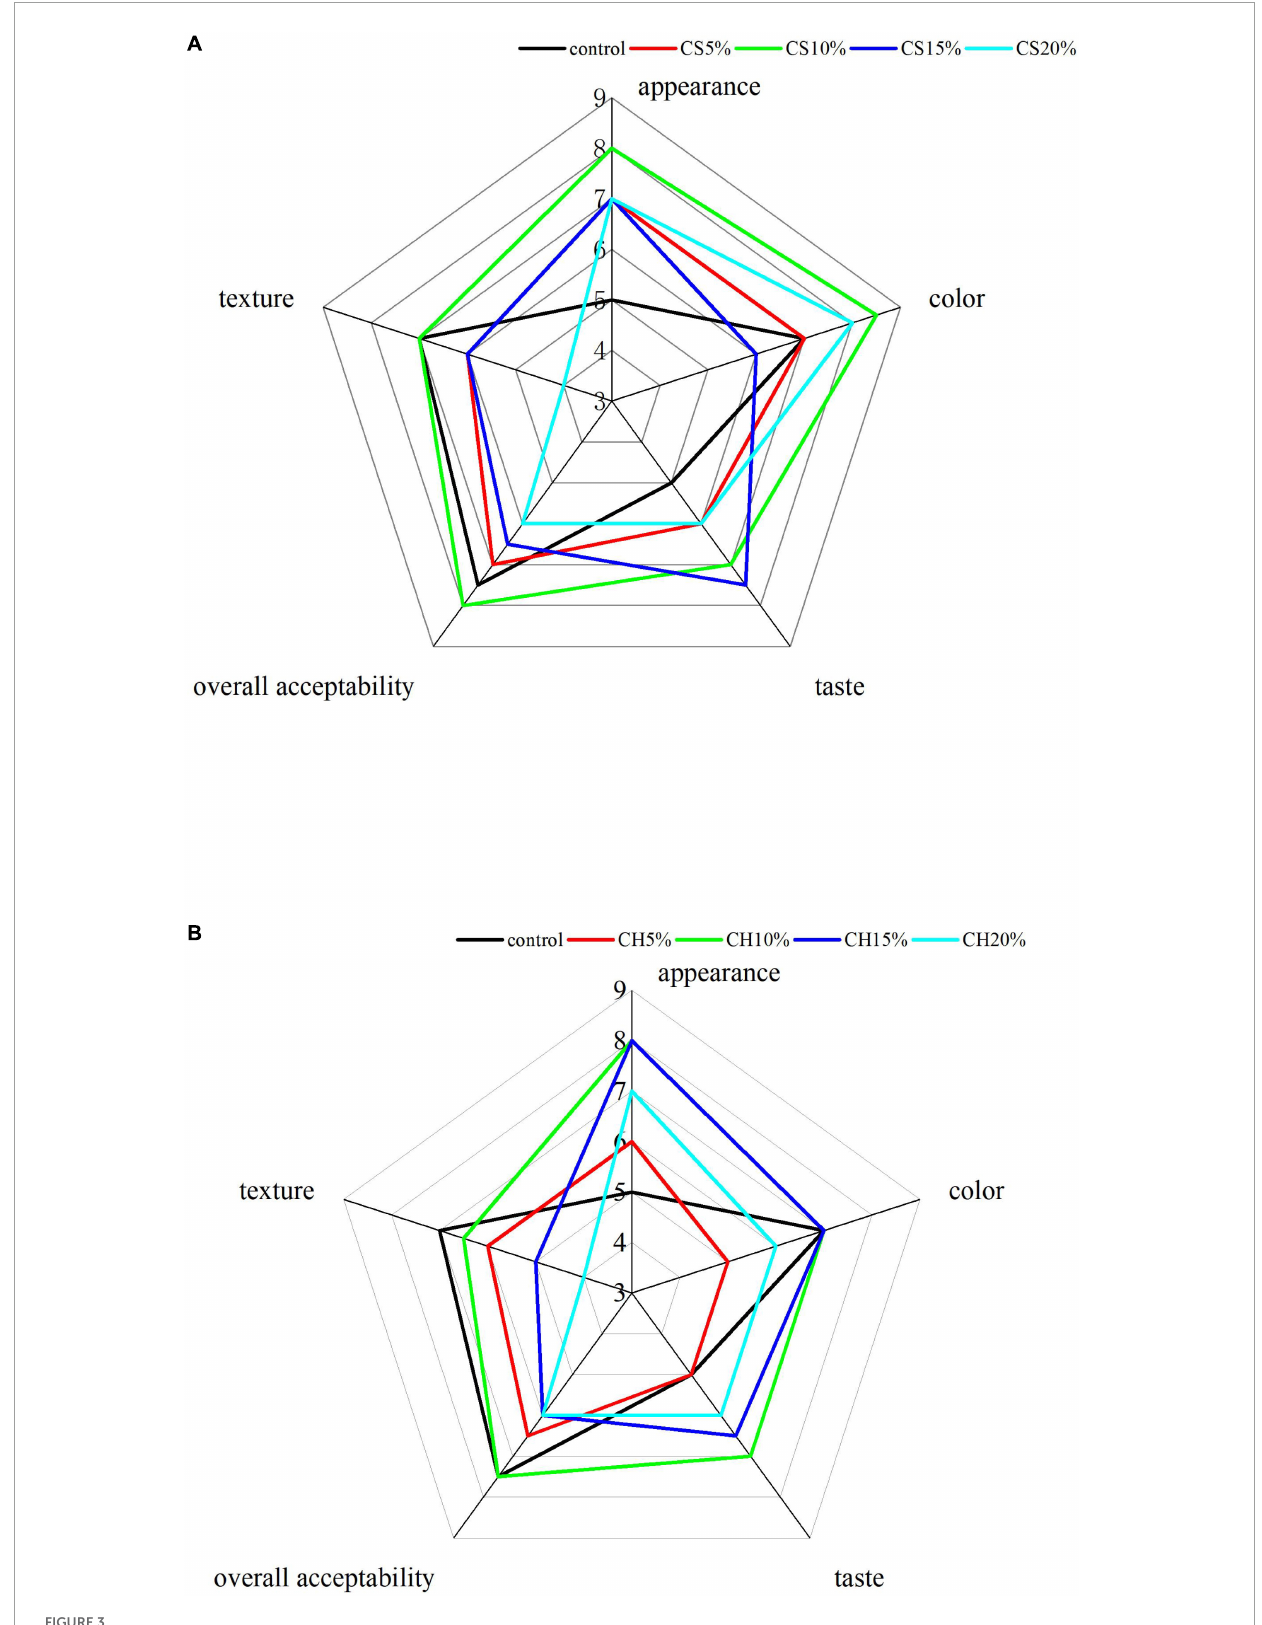
FIGURE3 The sensory properties of (A) biscuits with different additions of CS and (B) biscuits with different additions of CH. CS 5, CS 10, CS 15, and CS 20% were CS-biscuits at different addition ratio (CS/flour = 5, 10, 15, and 20%); CH 5, CH 10, CH 15, and CH 20% were CH-biscuits at different addition ratio (CH/flour = 5, 10, 15, and 20%); CH indicates chitin; CS indicates crayfish